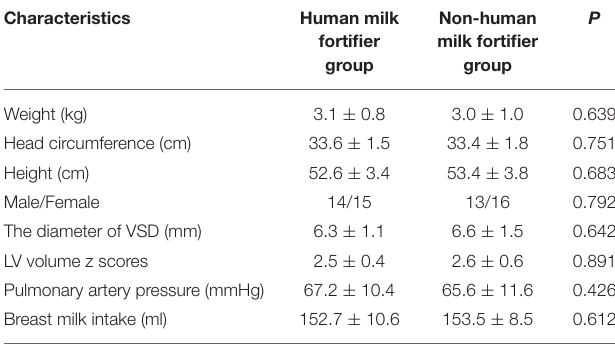
TABLE 2 | Comparison of baseline characteristics of the two groups.